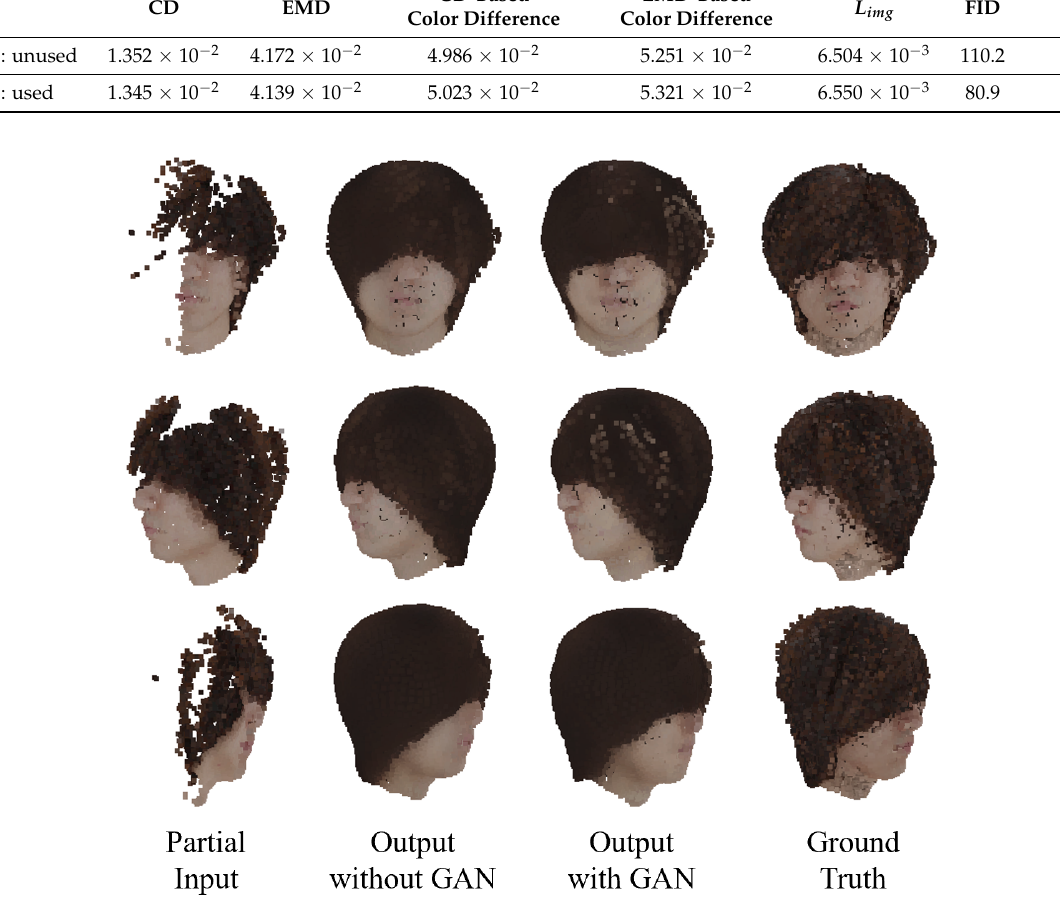
Figure 8. Completion example 1 using the proposed